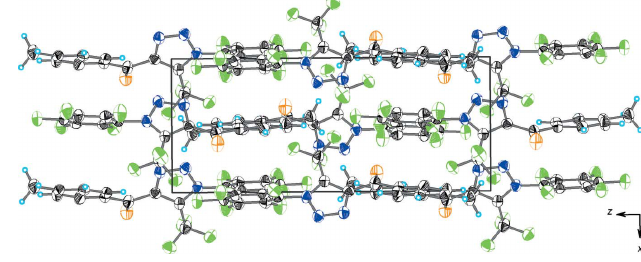
Figure 3 A view along the b -axis direction of the crystal packing of (I).